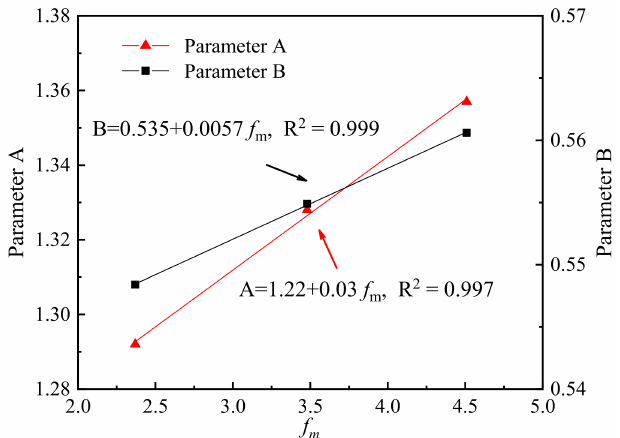
Figure 7. Correlations between the fitting parameters and the